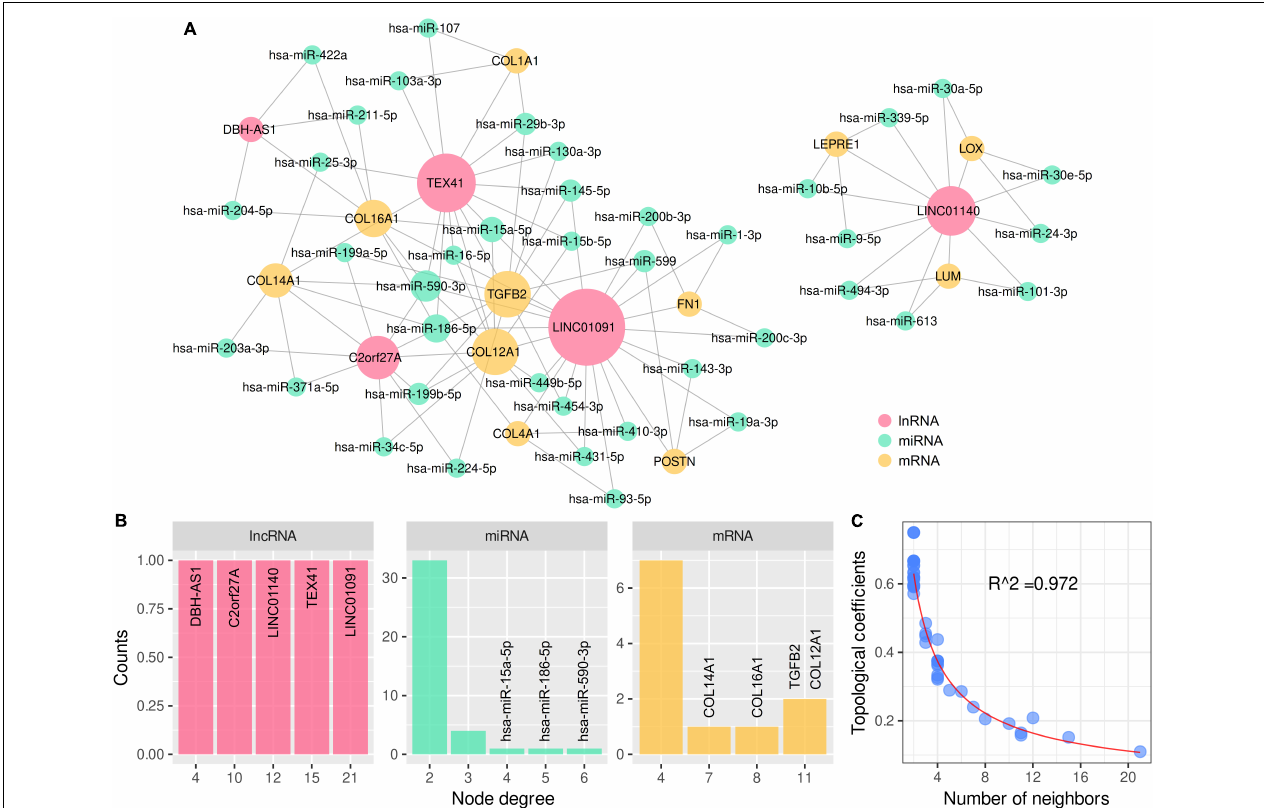
FIGURE 6 | LncRNA–miRNA–mRNA network for 11 ARVC hub genes with topological analysis. (A) The complete lncRNA-miRNA-mRNA network. (B) The distributions of the node degrees of lncRNA, miRNA, and mRNA, respectively. (C) The distribution of the topological coefficients indicating the favorable fitness of scale-free network